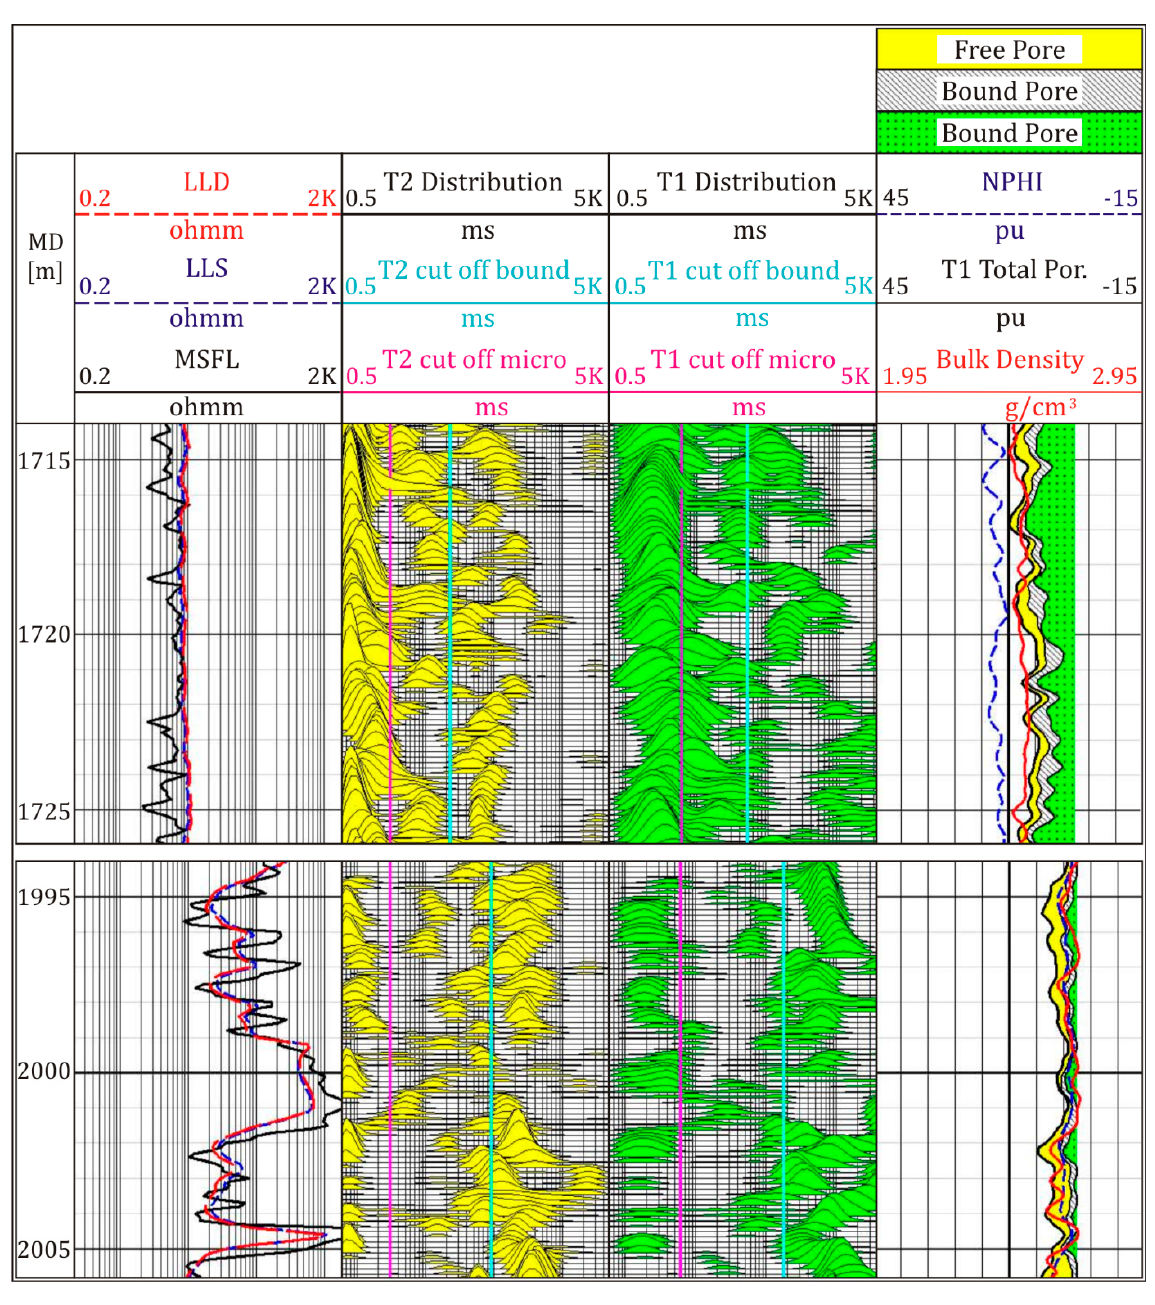
Figure 12. Selected sections of curves illustrating the resistivity and NMR logging results in the shaly ‐ sandstone (upper part) and carbonate (lower) formations (L4 borehole in the Carpathian Foredeep; first track—measured depth, second—three resistivity logs: MSFL ‐ the shortest radius of investigation resistivity log, LLS ‐ middle and LLD ‐ deep radius of investigation, third and fourth tracks—T2 and T1 distributions with cut ‐ off lines separating the pore space occupied by clay water (to the left from rose line), capillary water (between rose and blue lines) and free water (to right from blue line), fifth track—results of the interpretation of the NMR log: yellow area ‐ free pore, dynamic porosity, grey ‐ bound pore, green ‐ micro pore, blue line—neutron porosity, red—bulk density, black ‐ total porosity from T1.